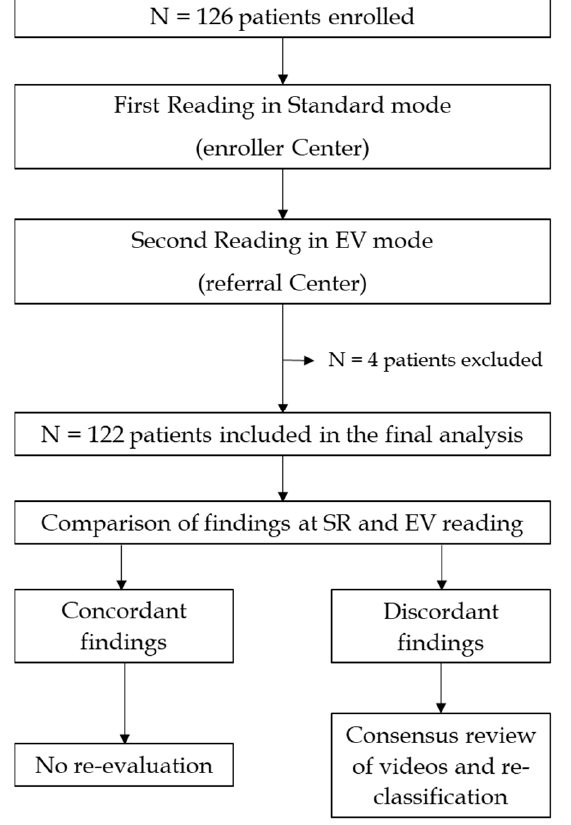
Figure 1. Study design.